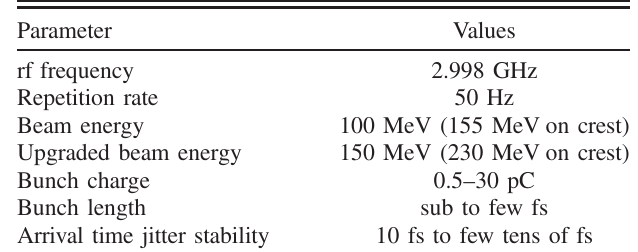
TABLE I. Parameters for the rf systems and the electron beam at the ARES linac.